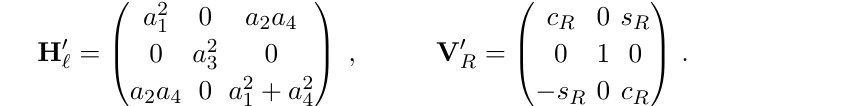
charges q such that the transformation phases are e 2 πiq n /n . n n charges are expressed as multiples of the arbitrary charges q F